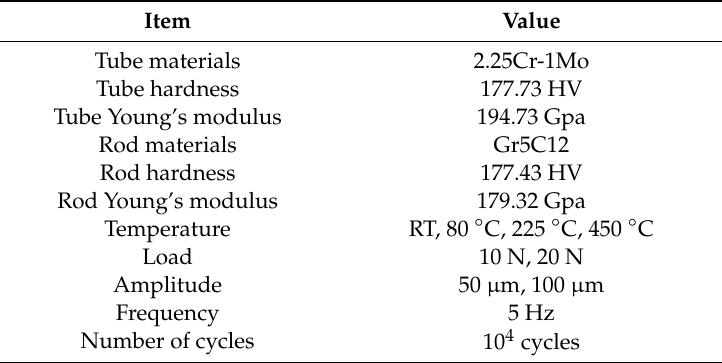
Table 2. Experimental parameters for fretting wear